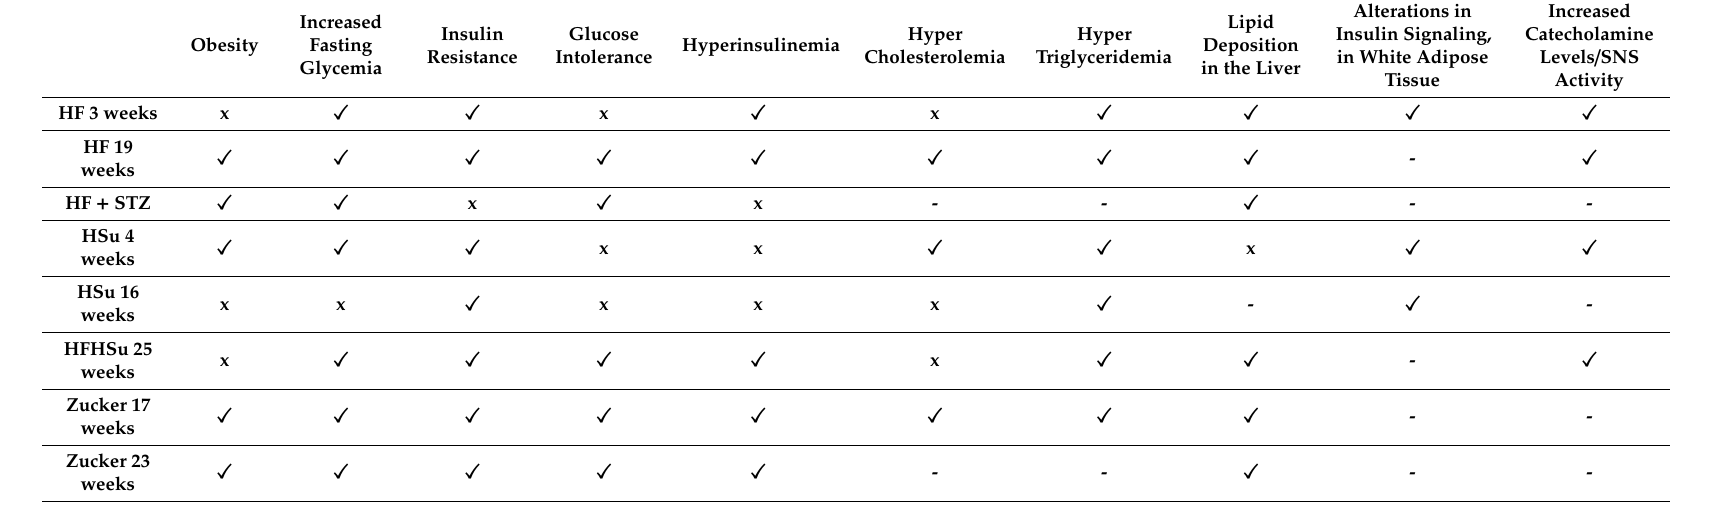
Table 3. Summary of the main pathological features of animal models of dysmetabolism. Insulin Glucose Obesity Resistance Intolerance in White Adipose